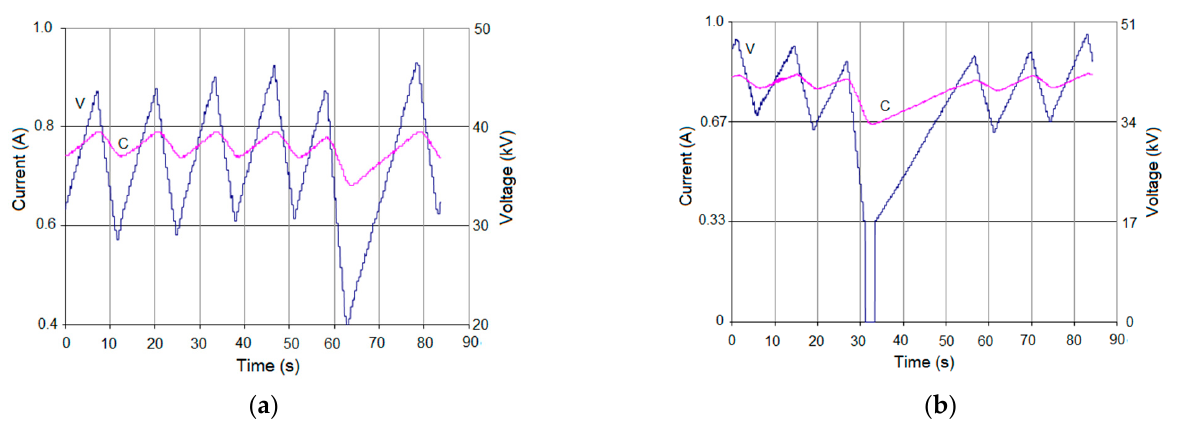
Figure 16. Evolutions of voltage and current in a section in cases of: ( a ) light discharge; ( b ) severe Figure 16. discharge.